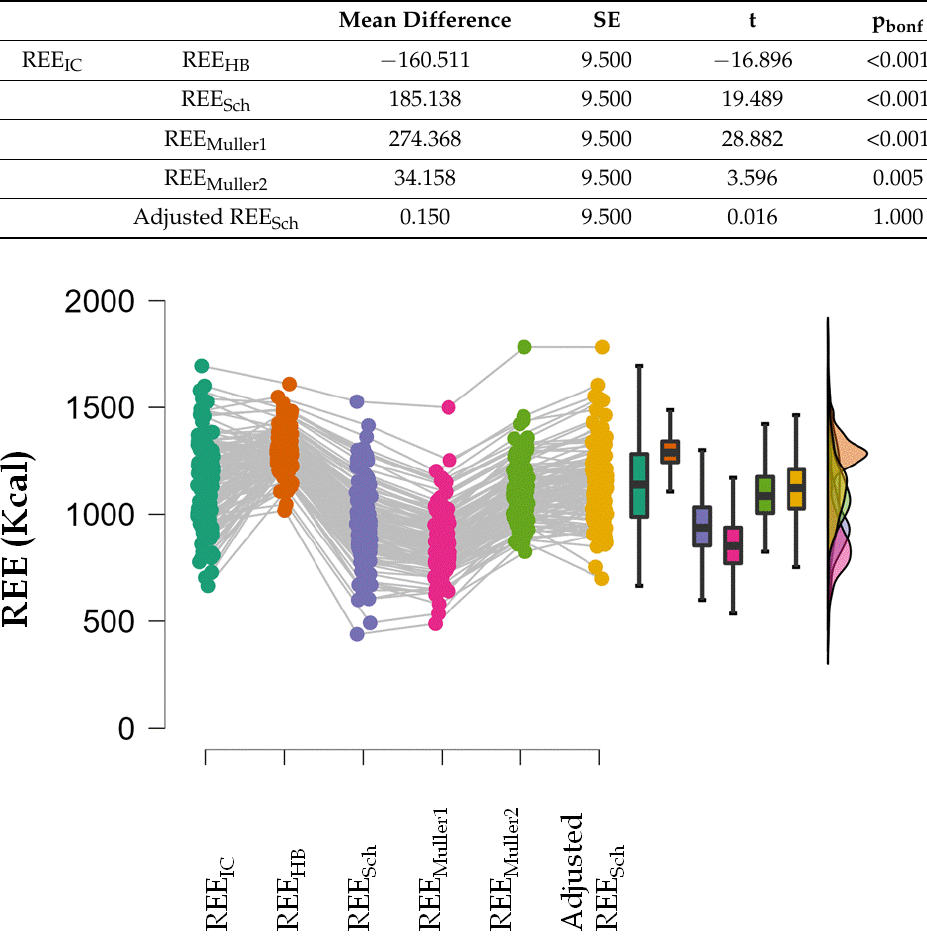
Figure 2. Raincloud plot of repeated measures ANOVA showing the distribution of the estimated REE and REE IC